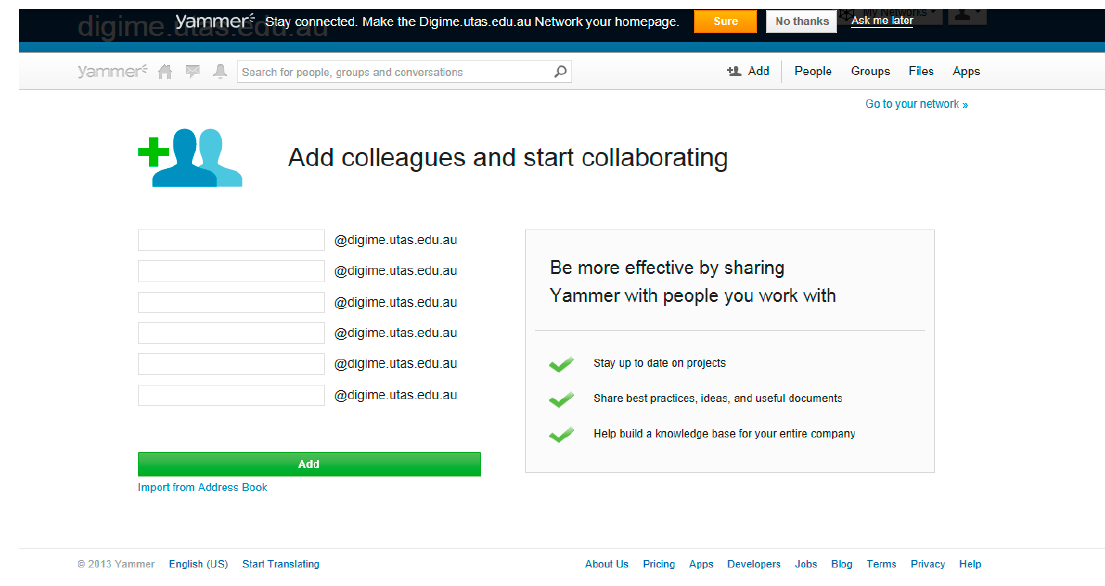
Figure 2. digiMe ‘My Community’ page.